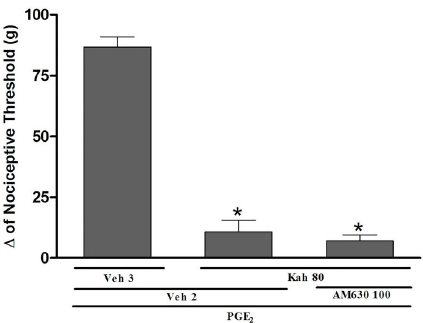
Figure 4. The CB 2 receptor antagonist did not block kahweol- induced peripheral antinociception in hyperalgesic paws. The antinociceptive response was measured by the paw pressure test. Prostaglandin E 2 (PGE 2 ) injection (2 m g/paw) was done at time 0, AM630 (100 m g/paw) was injected at time 165 min, and kahweol (Kah; 80 m g/paw) was given at 175 min. Measurements were made prior to and 180 min after PGE 2 administration. Data are reported as means ± SE (n=5) of D nociceptive threshold measured in grams (g). *P o 0.05 compared to PGE 2 + Veh 2 + Veh 3-injected group (ANOVA and Bonferroni ’ s test). There was no signi fi cant difference between (PGE 2 + Veh 2 + Kah 80) and (PGE 2 + AM630 100 + Kah 80)-injected groups. Veh (vehicle) 2: 10% DMSO in saline; Veh 3: sterile saline solution (0.9% VDM11 (2.5 m g/paw) alone, did not induce antinociception, whereas when co-administered with low-dose kahweol (40 m g/paw), its antinociception was potentiated [F (5, 18) =111.9, P o 0.0001] (Figure 5A). MAGL and FAAH inhibi- tors, JZL184 (selective for MAGL, 4 m g/paw) [F (5,18)